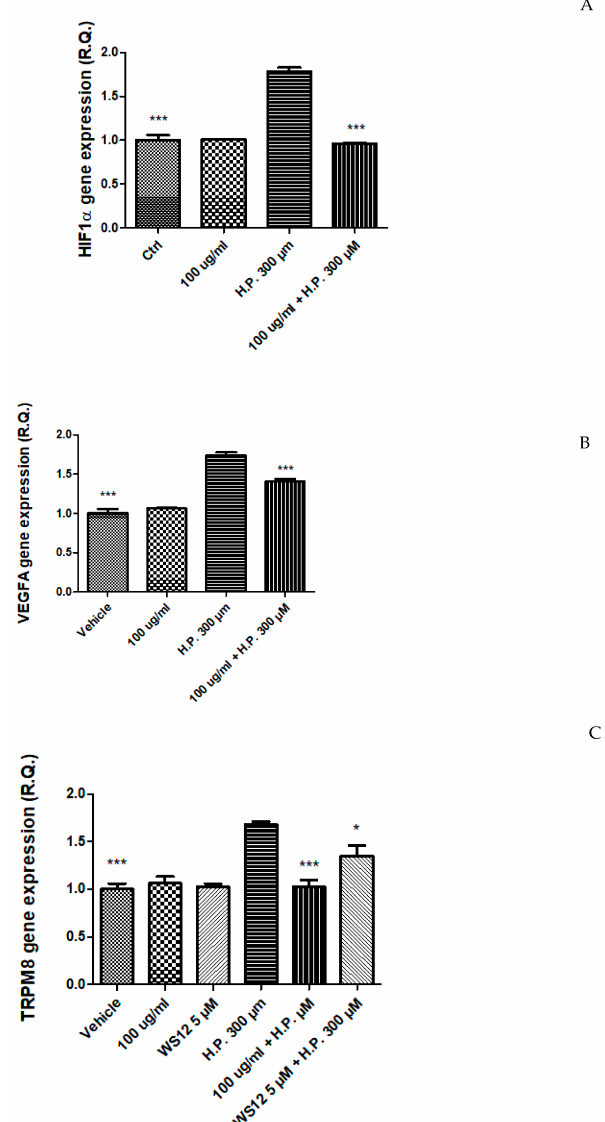
Figure 5. ( A ) Inhibitory effect of the ethyl acetate extract 100 µ g/mL from the aerial parts of Pelargonium quercetorum on HIF1 α gene expression in human colon cancer HCT116 cells exposed to hydrogen peroxide (H.P.) 300 µ M. *** p < 0.001 vs. H.P. group. ( B ) Inhibitory effect of the ethyl acetate extract 100 µ g/mL from the aerial parts of Pelargonium quercetorum on VEGFA gene expression in human colon cancer HCT116 cells exposed to hydrogen peroxide (H.P.) 300 µ M. *** p < 0.001 vs. H.P. group. ( C ) Inhibitory effect of the ethyl acetate extract 100 µ g/mL from the aerial parts of Pelargonium quercetorum on TRPM8 gene expression in human colon cancer HCT116 cells exposed to hydrogen peroxide (H.P.) 300 µ M. *** p < 0.001, * p < 0.05 vs. Ctrl